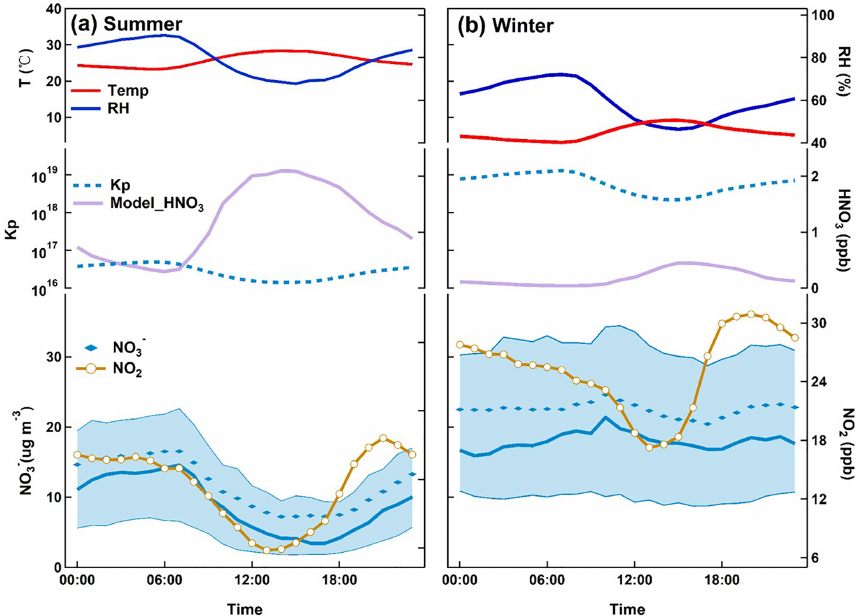
Figure 5. Diurnal variation of particulate nitrate in (a) summer and (b) winter. For nitrate, bold solid lines are the median values, shaded areas represent percentiles of 75% and 25% and diamonds represent mean values. Diurnal averages of NO 2 and modeled nitric acid mass concentrations are also provided with temperature and